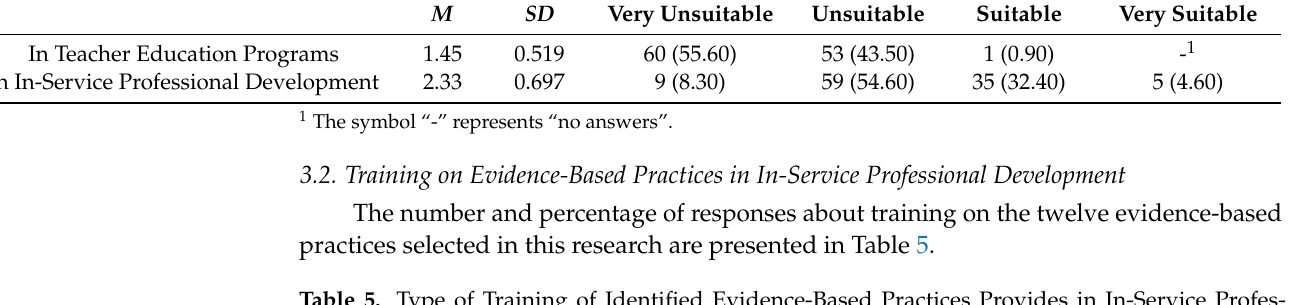
Table 5. Type of Training of Identified Evidence-Based Practices Provides in In-Service Profes- sional